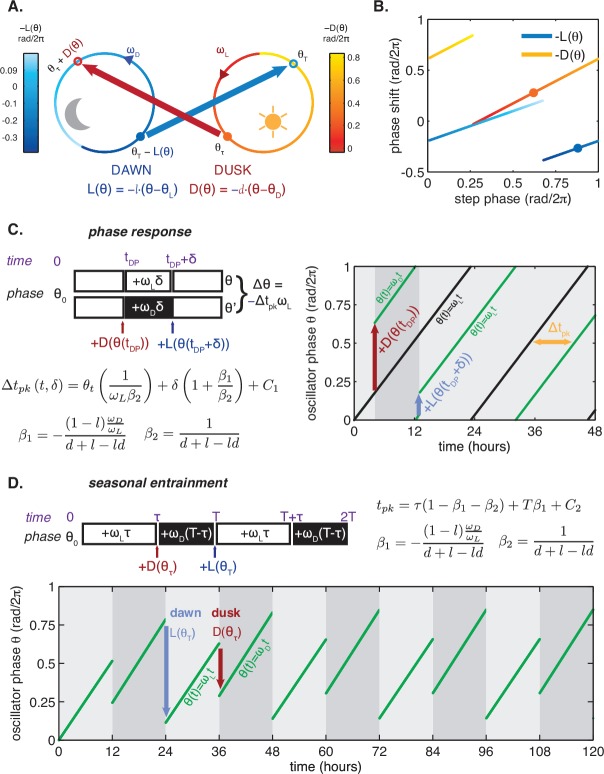
Phase oscillator with step response framework.(A) Schematic of the framework. In the light portion of the day, the oscillator runs along the ‘light’ limit cycle (orange) and accumulates phase θ at constant rate ωL; in the dark, the oscillator runs along the ‘dark’ limit cycle (blue) with frequency ωD. At dawn (solid blue circle) and dusk (solid orange circle), the oscillator transitions between the light and dark limit cycles (blue and orange arrows) and incurs instantaneous phase shifts given by L(θ) at dawn and D(θ) at dusk.  L(θ) and D(θ)can be approximated by linear functions of phase, such that L(θ)=−l(θ−θL) and D(θ)= −d(θ−θD). Colors along the ‘light’ and ‘dark’ limit cycles indicate the magnitude of phase shifts due to light-to-dark (D(θ)) and dark-to-light (L(θ)) responses throughout the cycle for a single set of linearized L(θ) and D(θ), shown in (B), generated by bootstrapping the measurements in Figure 3E–F. θ=0 refers to the minimum of the KaiC phosphorylation rhythm. (B) One set of linearized step response functions L^lin(θ^) and D^lin(θ^) for the KaiABC oscillator determined by SDS-PAGE analysis of KaiC phosphorylation rhythms (see Figure 3E–F). The functions plotted represent one pair of L^lin(θ^) and D^lin(θ^) generated by bootstrapping (see Computational Methods). Colors denote phase shift magnitude as in (A). Solid circular markers correspond to dawn and dusk transitions in (A). (C) (left) Schematic of phase response analysis in the phase oscillator framework. The phase shift is a linear function of the dark pulse time (tDP) and duration (δ) if L(θ) and the D(θ) are linear functions. Slopes of linear dependencies on tDP and duration δ can be computed based on clock frequencies in light and dark (ωL, ωD) and slopes of L(θ) and D(θ) functions. (right) Simulation of a phase response experiment for a phase oscillator with experimentally determined parameters (ωL, ωD, l, and d from the same bootstrapped parameter set as in (B)). A 9 hr dark pulse applied 4 hr after the beginning of the simulation to an oscillator (green) results in a ≈8 hr phase delay relative to a control (black) that remains in light throughout the simulation. (D) (top) Schematic of analysis of seasonal entrainment in the phase oscillator framework. Entrained phase is a linear function of day length (τ) and driving period (T) if L(θ) and the D(θ) are linear functions. Slopes of linear dependencies on τ and T can be computed based on four parameters (ωL, ωD, l, and d). (bottom) Simulation of entrainment to a LD 12:12 cycle for a phase oscillator with experimentally determined parameters (ωL, ωD, l, and d from the same bootstrapped parameter set as in (B)).